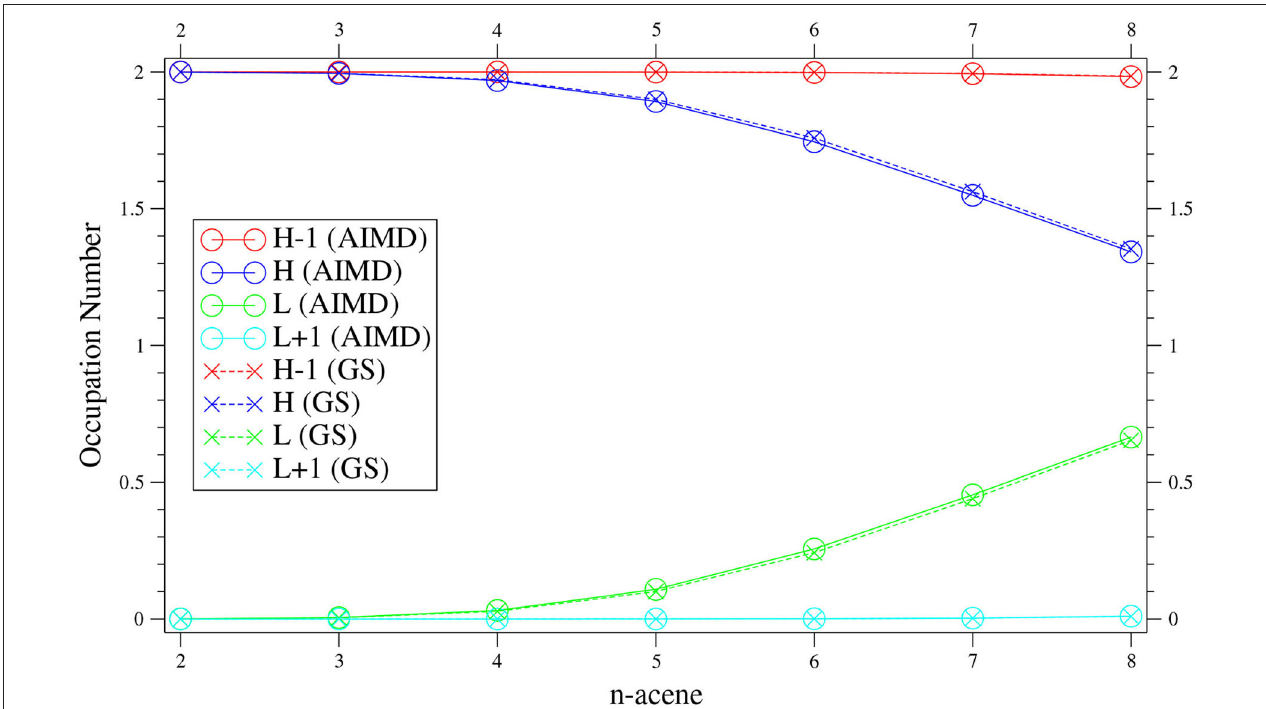
FIGURE 4 | Active orbital occupation numbers (HOMO − 1, HOMO, LUMO, and LUMO+1) of n -acene, obtained with the TAO-AIMD simulations at 300 K and GS calculation, calculated by TAO-LDA.